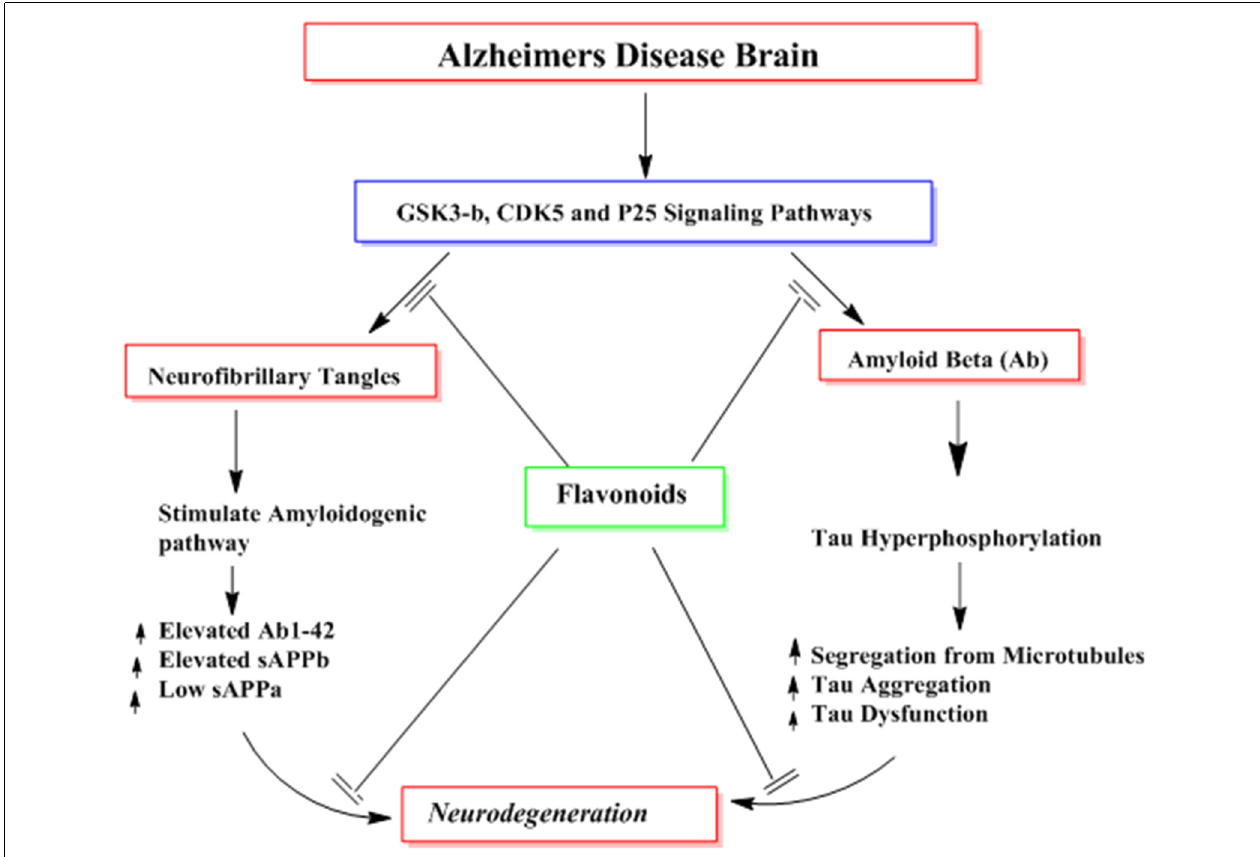
FIGURE 10 | The probable mechanisms of flavonoids in inhibiting different signaling pathways implicated in the formation of neurofibrillary tangles (NFTs) and amyloid plaques (A β